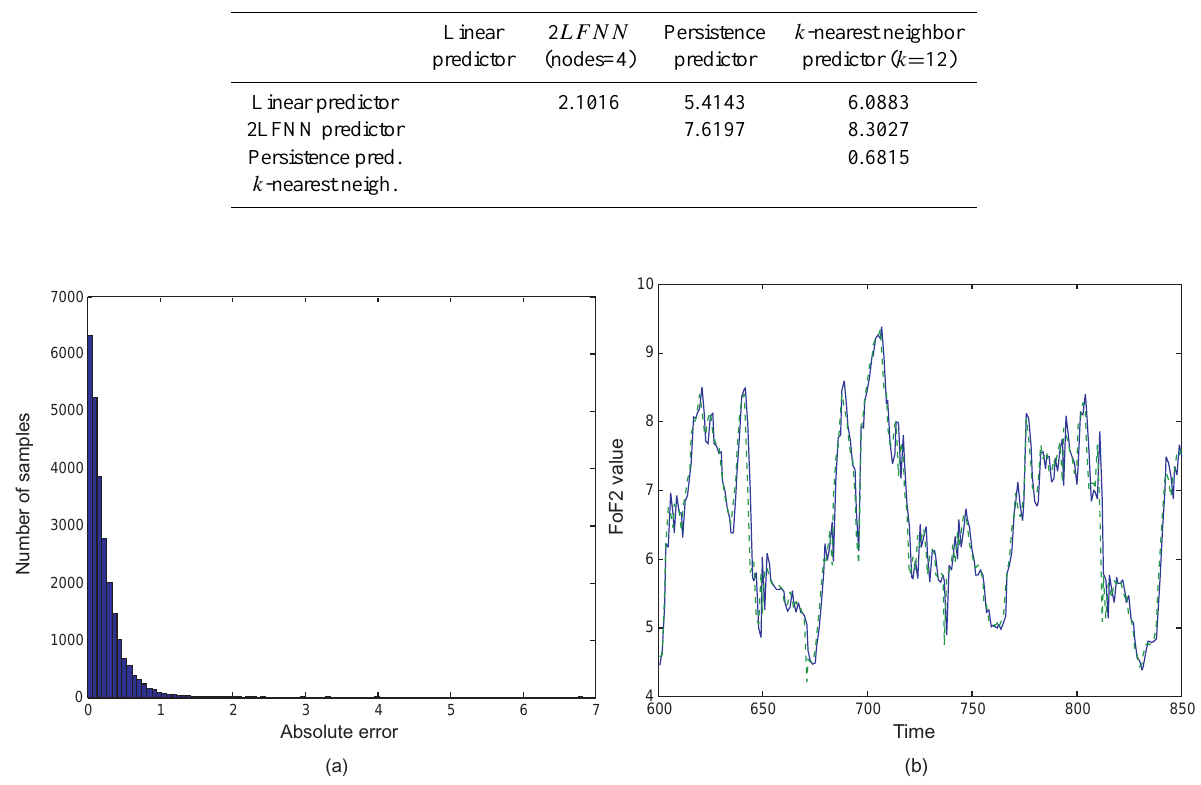
Table 2. Fifteen-minute ahead prediction. The table shows the values of the t -test that quantify the significance of the differences in the mean square error produced by two predictors when the test set is considered.